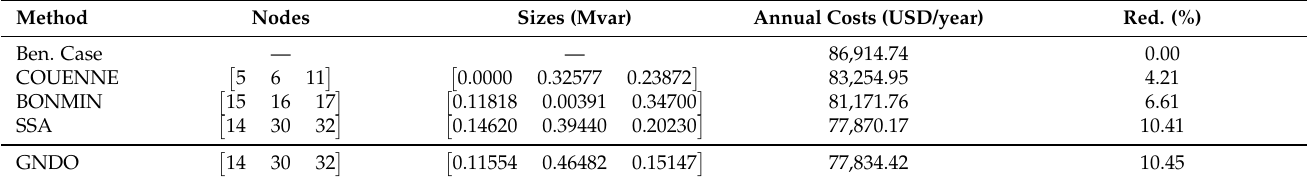
Table 7. Optimal solutions reached by the comparison and proposed optimization methods with fixed reactive power injection in a meshed grid configuration.